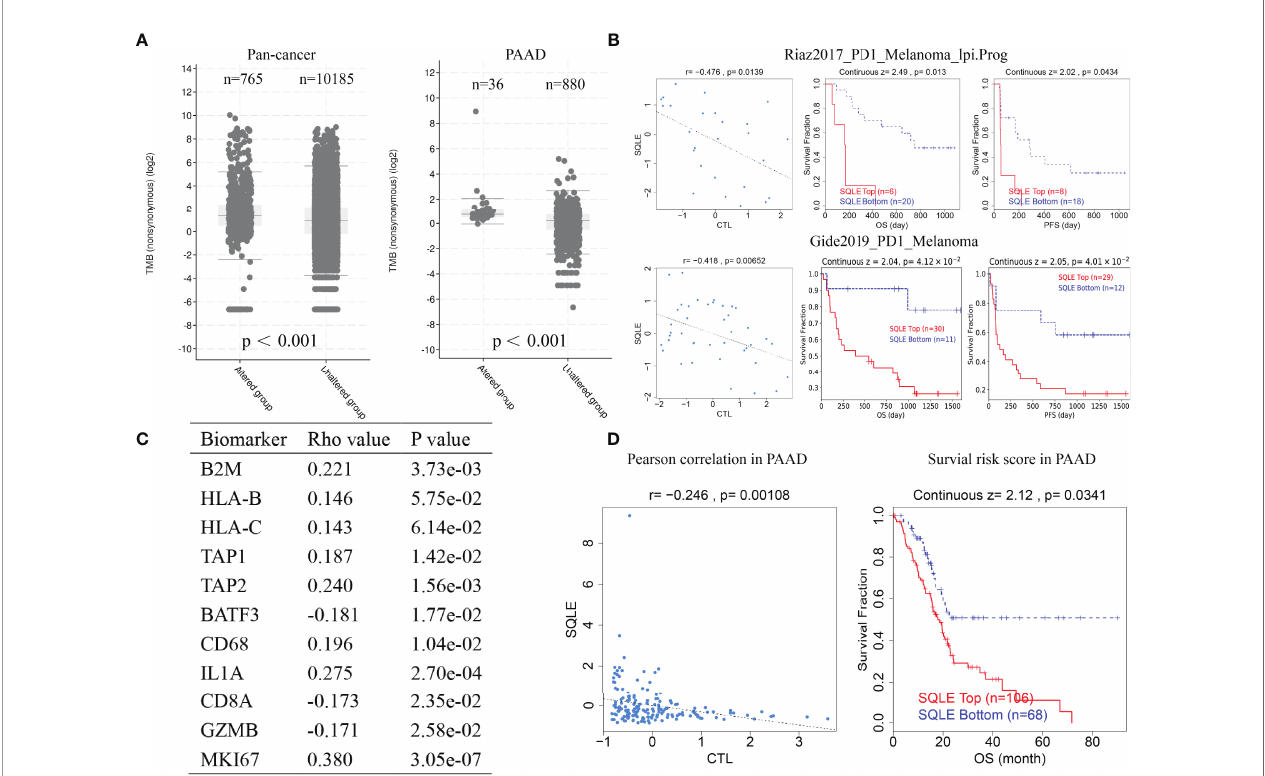
FIGURE 8 | SQLE predicts poor outcome of immunotherapy in cancer. (A) The association of SQLE alteration and tumor mutational burden (TMB) pan-cancer (left) and in PAAD (right). The Wilcoxon test was used for statistical analyses. (B) The results of two clinical trials suggest that SQLE expression correlates with the unfavorable outcome of immunotherapy in melanoma. (C) Correlation between SQLE expression and biomarkers of MHC (B2M, HLA-B, HLA-C, TAP1, and TAP2), dendritic cells (BATF3), macrophages (CD68 and IL1A), type-I anti-tumor responses (CD8A and GZMB), and cell proliferation (MKI67) in 178 tumor tissues of PAAD. (D) SQLE correlates with the outcome of immunotherapy in